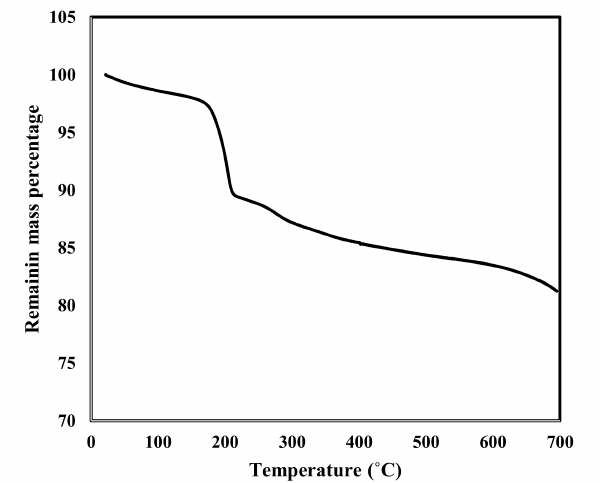
Figure 4. TEM images of Z, 1C3Z, 1C1Z, 3C1Z, and C greenly prepared via hydrothermal route (pH = 10, T = 250 ◦ C, t = 2.5 h) and calcination for 2 h at 300 ◦ C.